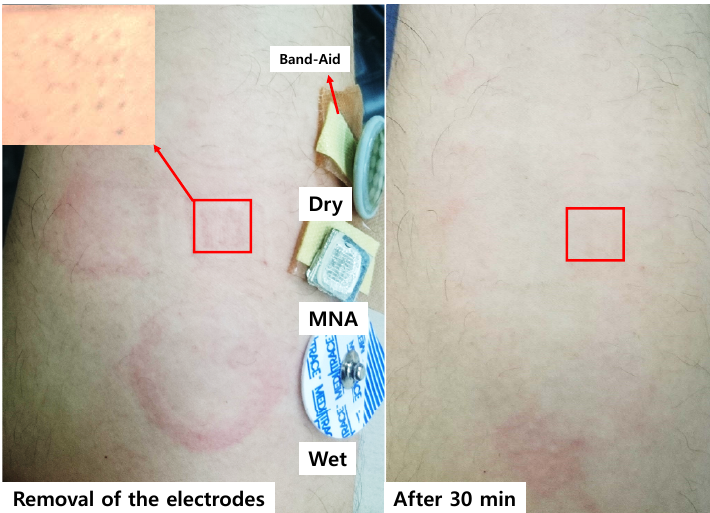
Figure 4. Examination of skin of the forearm wearing the electrodes for 8 h .